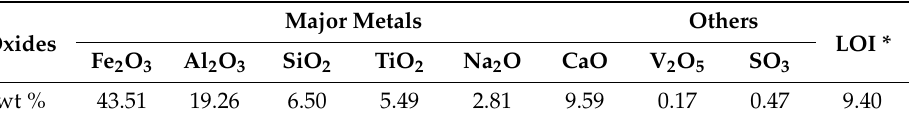
Table 1. Chemical analysis of AoG bauxite residue.